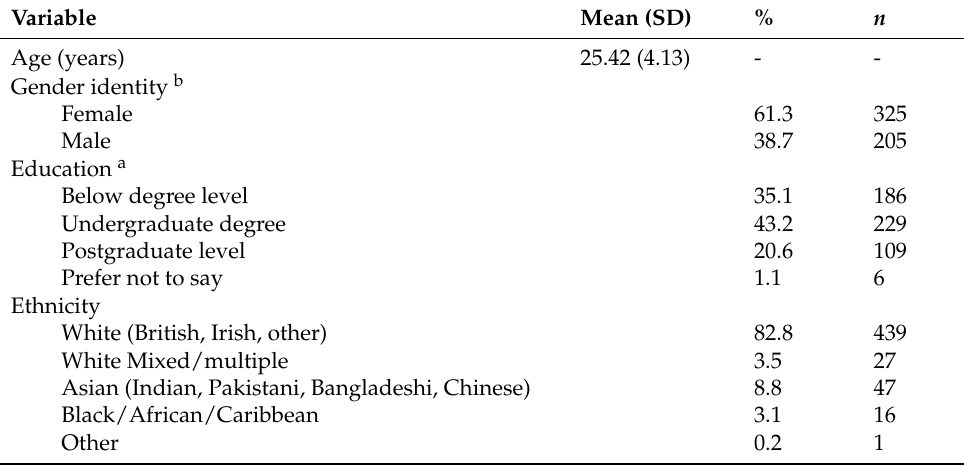
Table 1. Sociodemographic Characteristics of the Sample ( n =